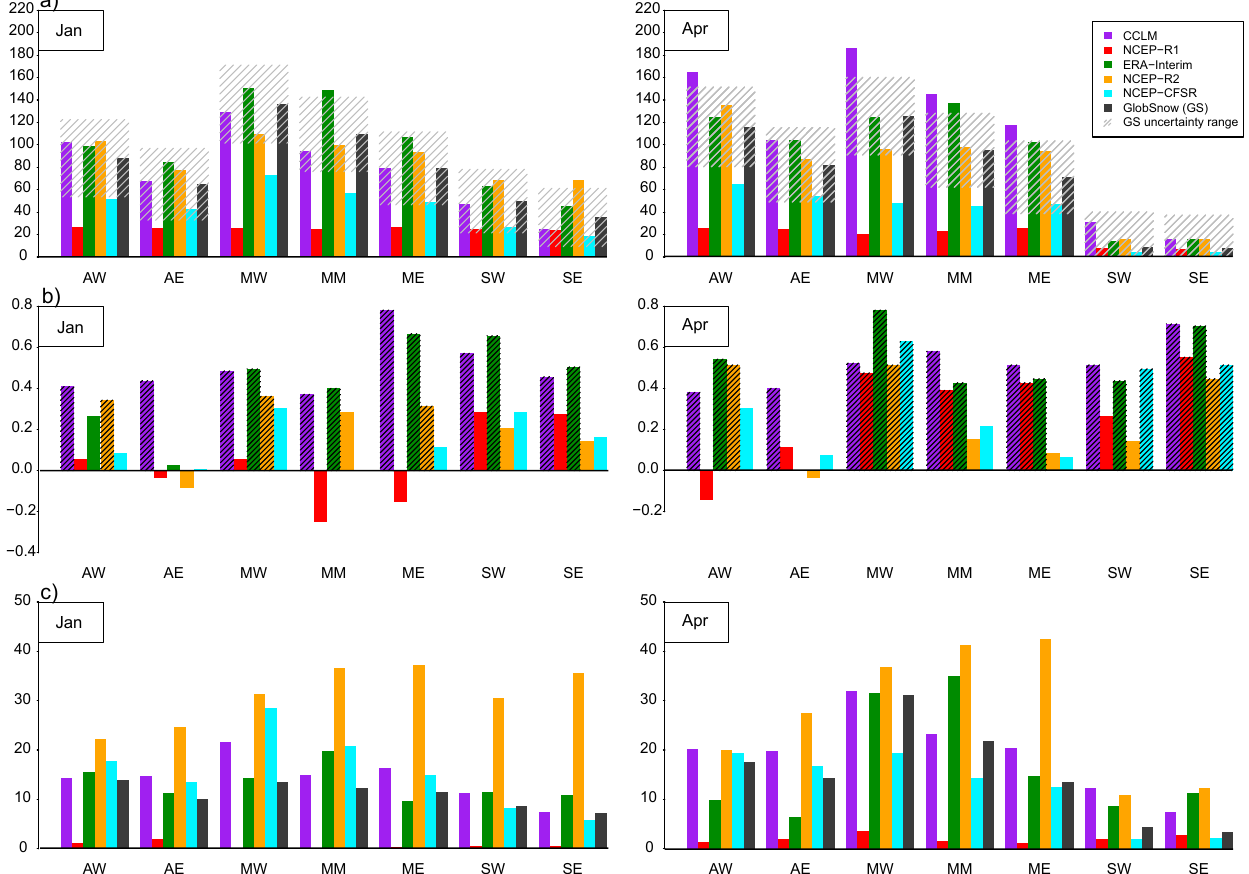
Fig. 4. (a) Regional variations of multi-year (1987–2010) monthly mean of SWE [mm] for January and April for CCLM, NCEP-R1, NCEP- R2, NCEP-CFSR, ERA-Interim and GlobSnow; (b) temporal correlation of monthly mean of SWE (1987–2010) of each dataset versus GlobSnow, statistical significant coefficients defined at the 95% level are marked with black hachures; (c) multi-year monthly standard deviation of SWE for 1987–2010. The gray shades with hachures represents the uncertainty range of GlobSnow. Locations of considered subregions (AW, AE, MW, MM, ME, SW and SE) are presented in Fig.